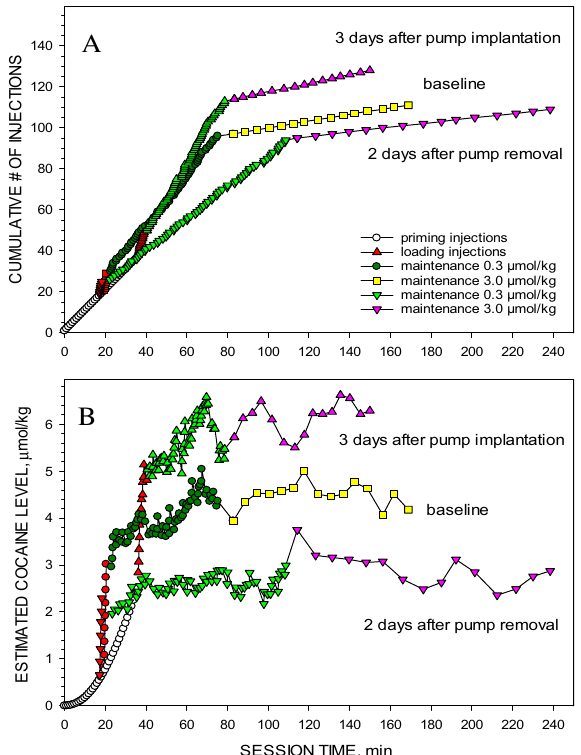
Figure 1. The effect of a 14-day infusion of SCH23390 on inter-injection intervals (Panel A ) and calculated cocaine levels (Panel B ) in representative sessions from the same rat before, during and after implantation of the Alzet pumps. Open circles represent programed response-independent (non-contingent) injections. The red symbols represent the loading injections. The green symbols represent injections in the first half of the maintenance phase at the 0.3 µmol/kg, while the pink symbols represent injections in the second half of sessions at the 3.0 µmol/kg unit